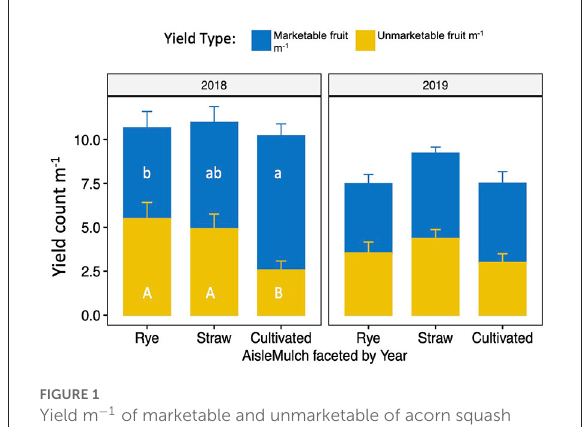
FIGURE1 Yield m − 1 of marketable and unmarketable of acorn squash grown using different aisle mulches, 2018 and 2019. Lowercase letters indicate significance groupings for marketable fruit m − 1 and uppercase letters indicate significance groupings for unmarketable fruit m − 1 . Groups with the same letter (or no letter) did not differ across aisle mulch treatments within the same year at p < 0.05.